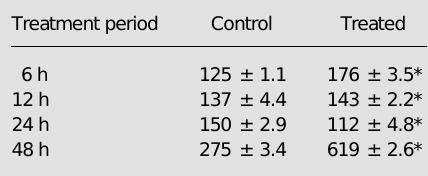
Table 2 - 32 P -3 incorporation into high mobility group protein (HMG) isolated from 7 µM retinol- treated rat Sertoli cells. HMGs were isolated from treated and untreated cells at each specified time as described in Mate- rial and Methods. Protein was determined by the method of Lowry and radioactivity by liquid scin- tigraphy. Data are reported as counts x 10 3 /mg protein (means ± SEM; N = 8). *P<0.01